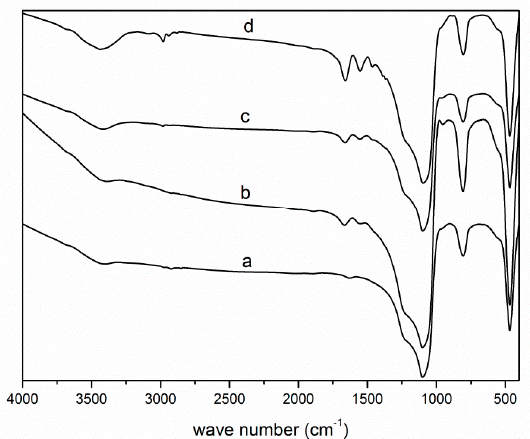
Figure 1. FTIR spectra of di ff erent silica in the synthesis of poly(NIPAAm- co -DEAEMA- co - t BAAm). a. NH 2 -grafted silica; b. CTA-grafted silica; c. poly(NIPAAm- co -DEAEMA- co - t BAAm)-grafted silica, the grafting density is 30%; d. poly(NIPAAm- co -DEAEMA- co - t BAAm)-grafted silica, the grafting density is 50%.